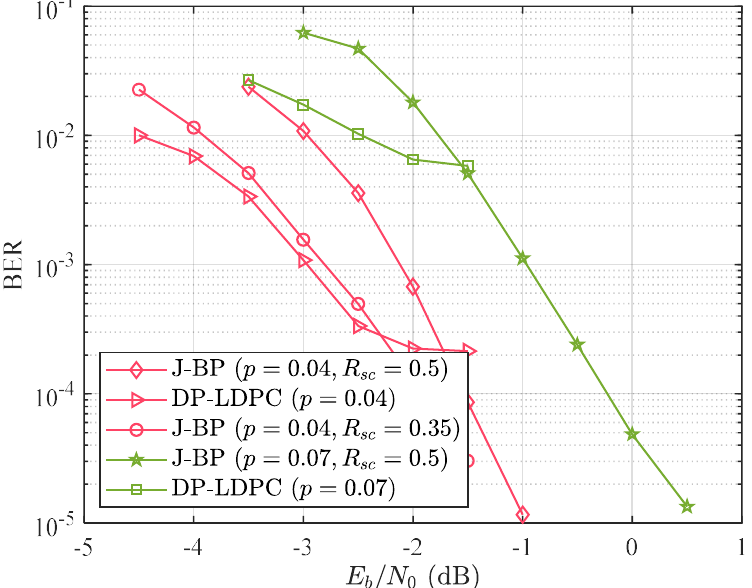
Figure 6. BER performance of the SD-PC JSCC system versus the DP-LPDC JSCC system with N sc = 512